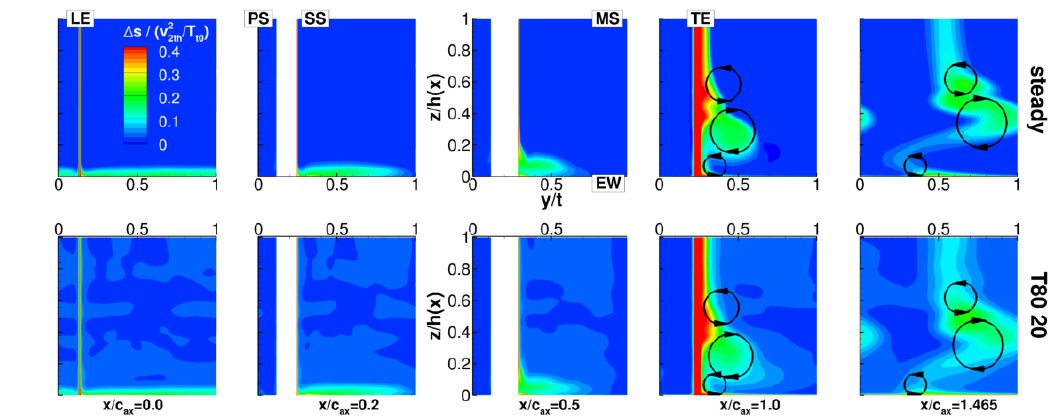
Figure 7. Comparison of the entropy distribution at different axial positions in the T106Div-EIZ in the steady and the unsteady T80 20